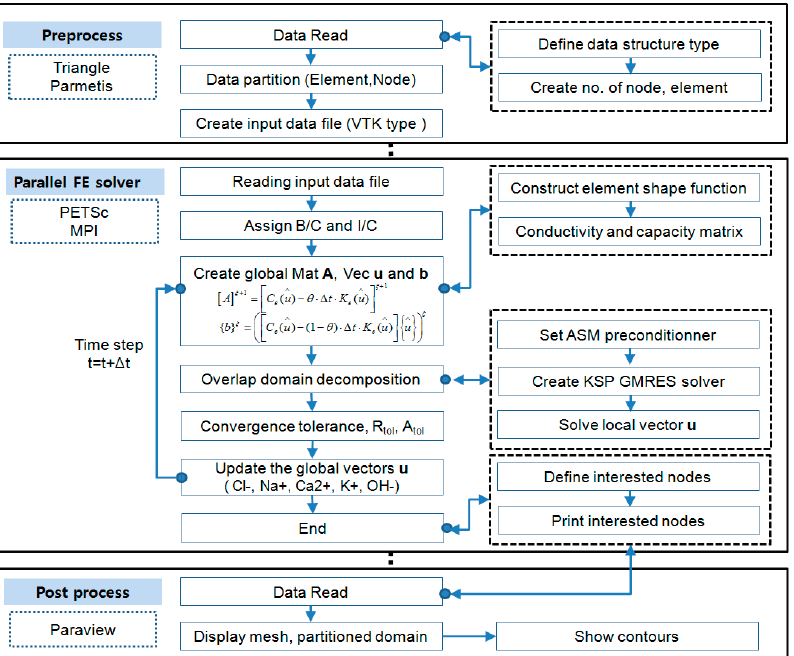
Figure 1. Framework of parallel finite element method based on PETSc (Portable, Extensible Toolkit for Scientific Computation) and Massage Passing Interface (MPI).